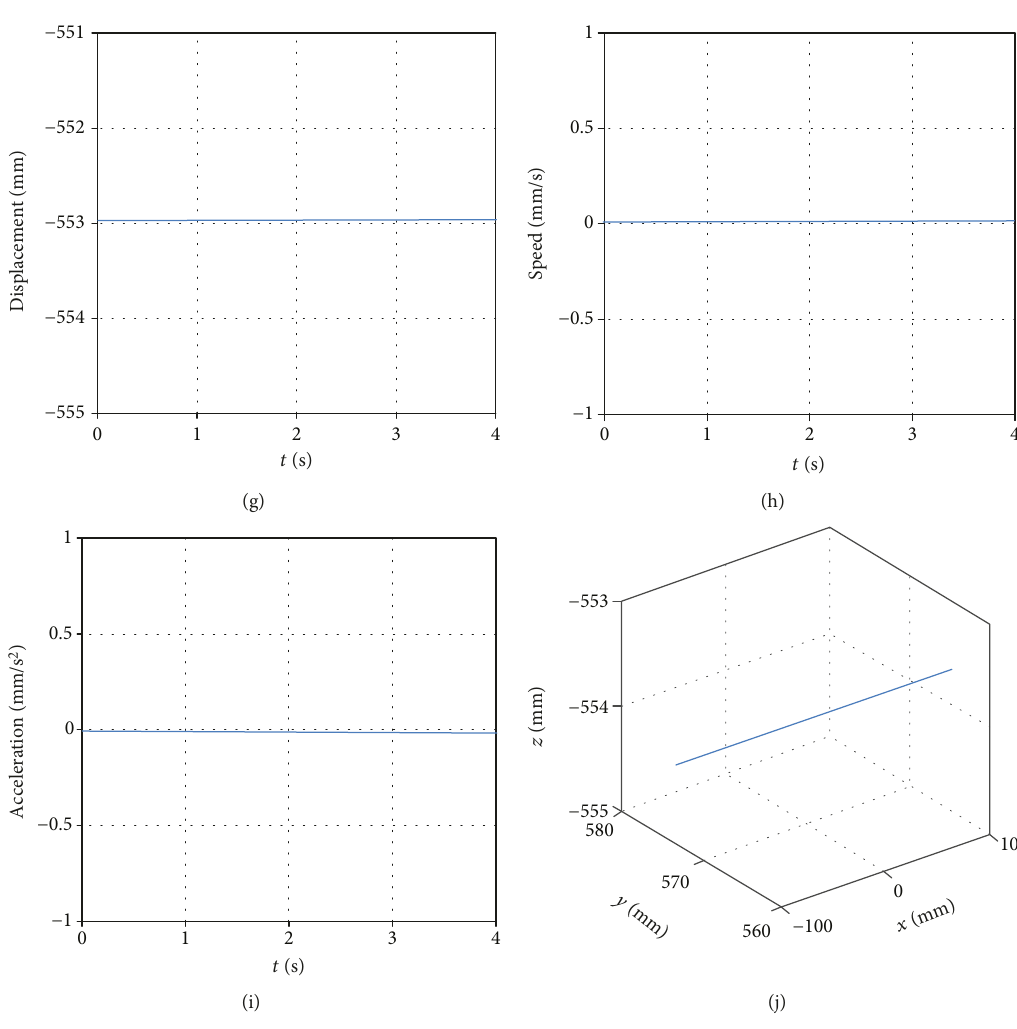
Figure 12: (a) The position of foot in the x direction. (b) The speed of foot in the x direction. (c) The acceleration of foot in the x direction. (d) The position of foot in the y direction. (e) The speed of foot in the y direction. (f) The acceleration of foot in the y direction. (g) The position of foot in the z direction. (h) The speed of foot in the z direction. (i) The acceleration of foot in the z direction. (j) Foot trajectory of the supporting